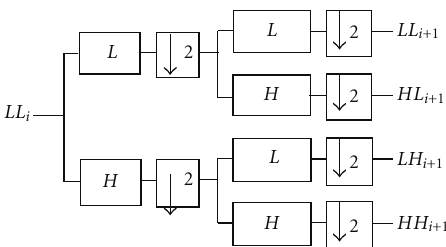
Figure 2: Splitting of subband into next higher Level four sub-